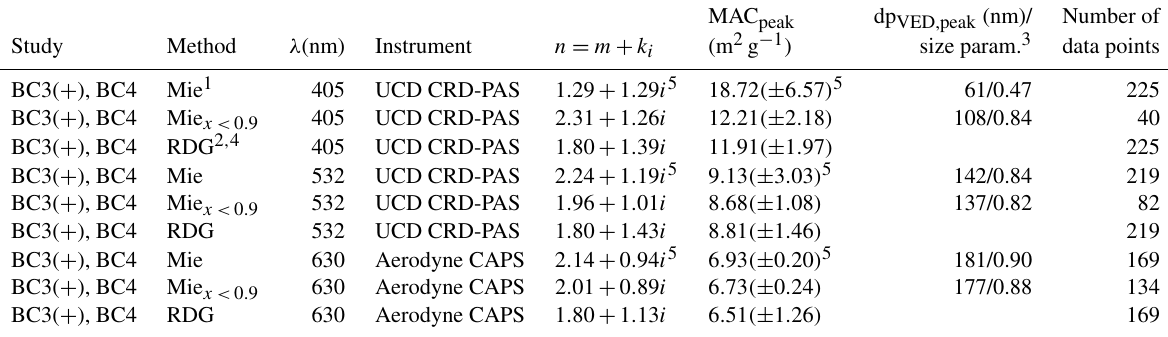
Table 1. Refractive indices for methane diffusion flame soot retrieved via fitting Mie theory and the RDG approximation to the σ abs obser- vations. Nascent and denuded data are combined (see text for